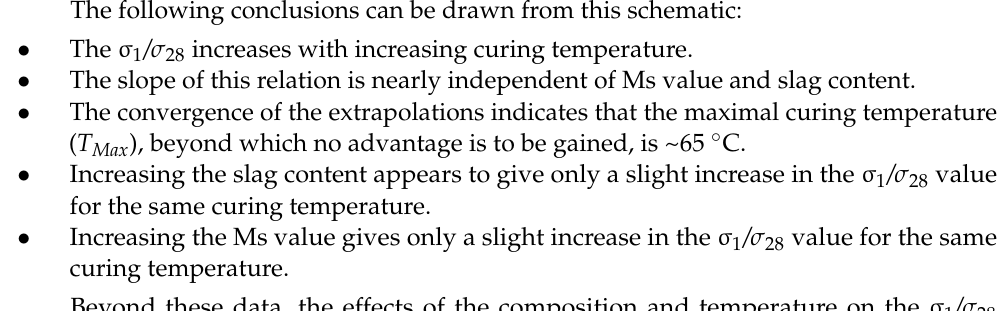
Figure 10. Schematic diagram summarising the effect of curing temperature, Ms value, and slag content on σ 1 / σ 28 .